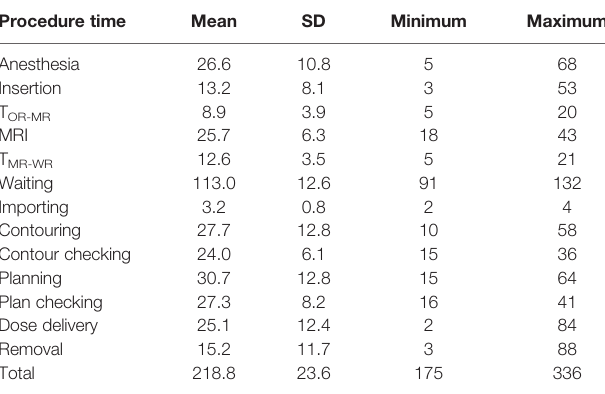
TABLE 2 | The associated time required for each stage